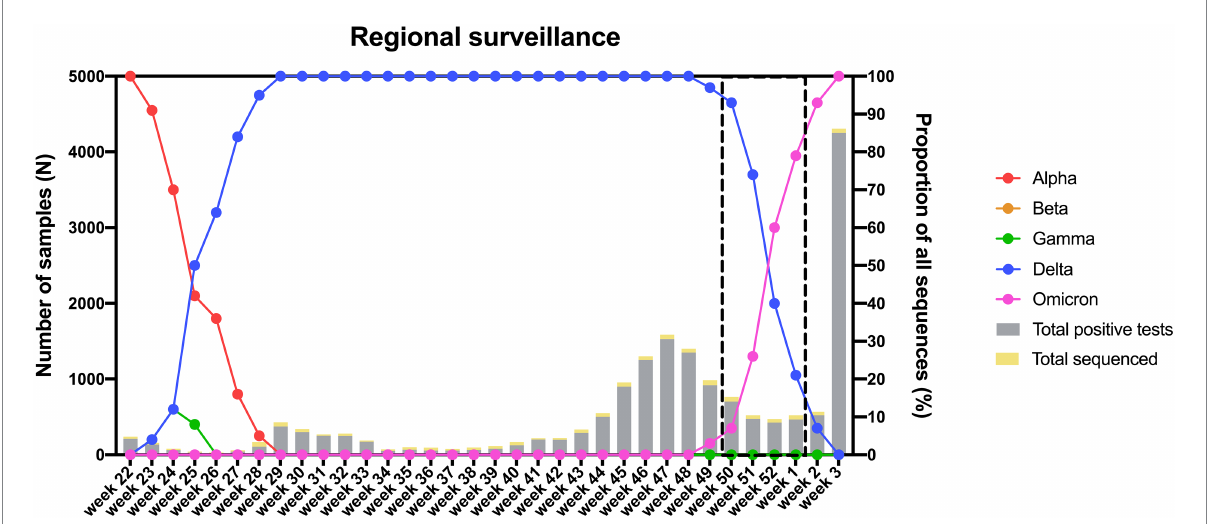
FIGURE 6 Distribution of circulating variants in the South Limburg region in time. Lines represent the relative proportion of each variant, while bars represent the total number of samples that were tested positive (gray) or were sequenced (yellow) in function of time. The transition period during which the Delta variant was replaced by Omicron is indicated by a dashed box.